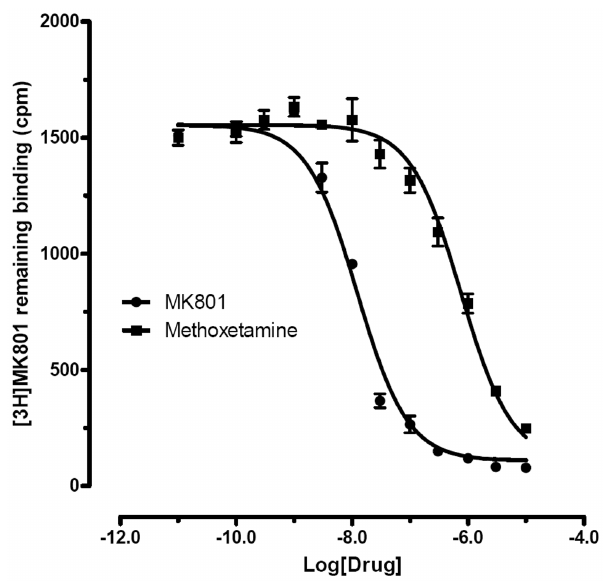
Figure 3. Representative Ki determination for methoxetamine in an NMDA receptor assay compared with reference com- pound MK-801 (dizocilpine). Shown are results from a typical experiment wherein methoxetamine Ki values were determined (Ki=337 + / 2 76 nM; N=3 separate determinations of this type) and MK-801 (Ki=5.7 + / 2 0.57 nM; N=3 separate determinations of this type).